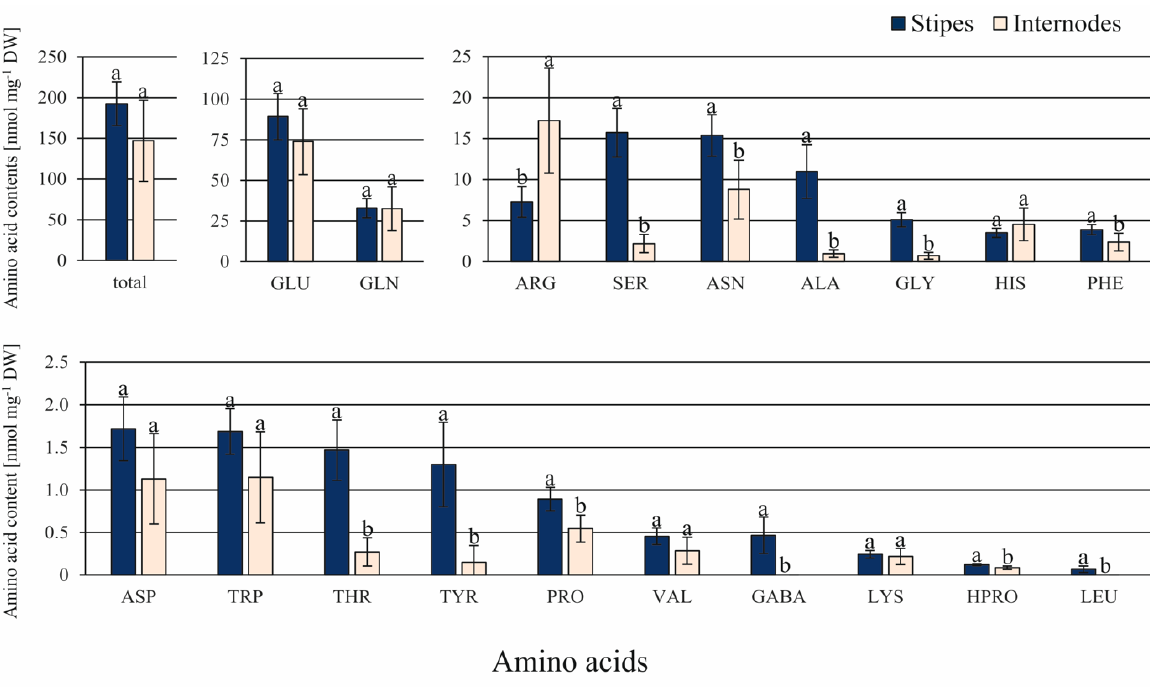
Figure 6. Contents of amino acids in the C. delgadii stipe and internode explants. Values represent the means ± standard deviation (SD) of 6 independent replicates. The Student’s t -test was used to estimate statistical significance of results for each amino acid. Data followed by different letters (a, b) were significantly different at p < 0.05.